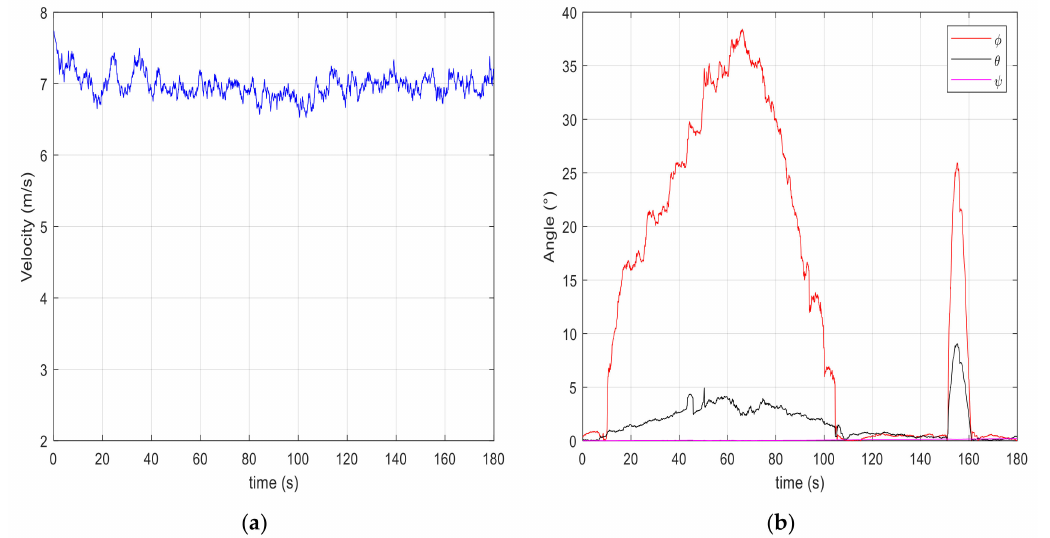
Figure 17. Data collection in dynamic conditions (test case 7, simulation of a roll variation from 0–40 ◦ ). ( a ) filtered velocity, ( b ) filtered Euler angles.